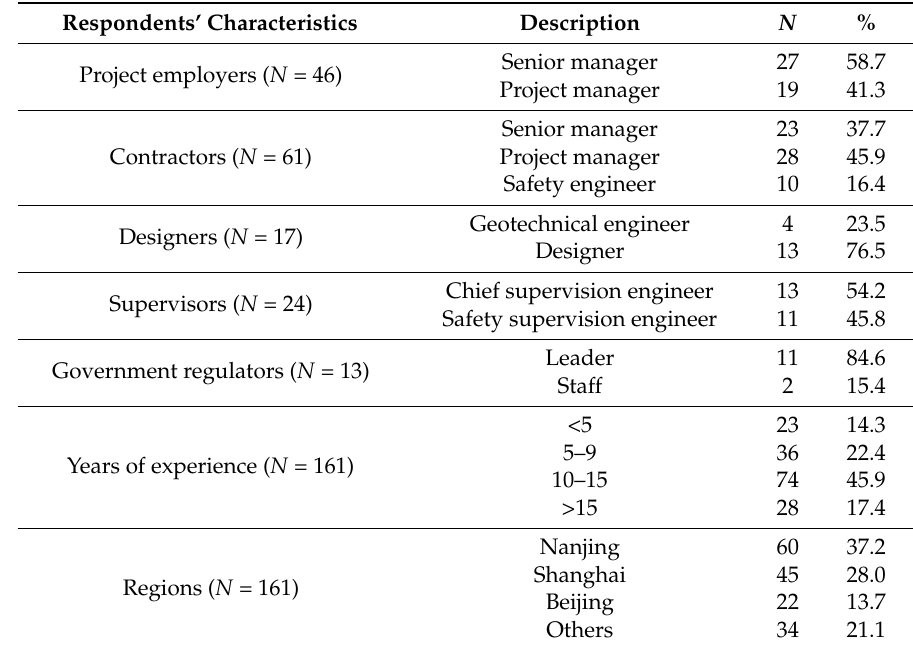
Table 3. Profile of the data collected from the